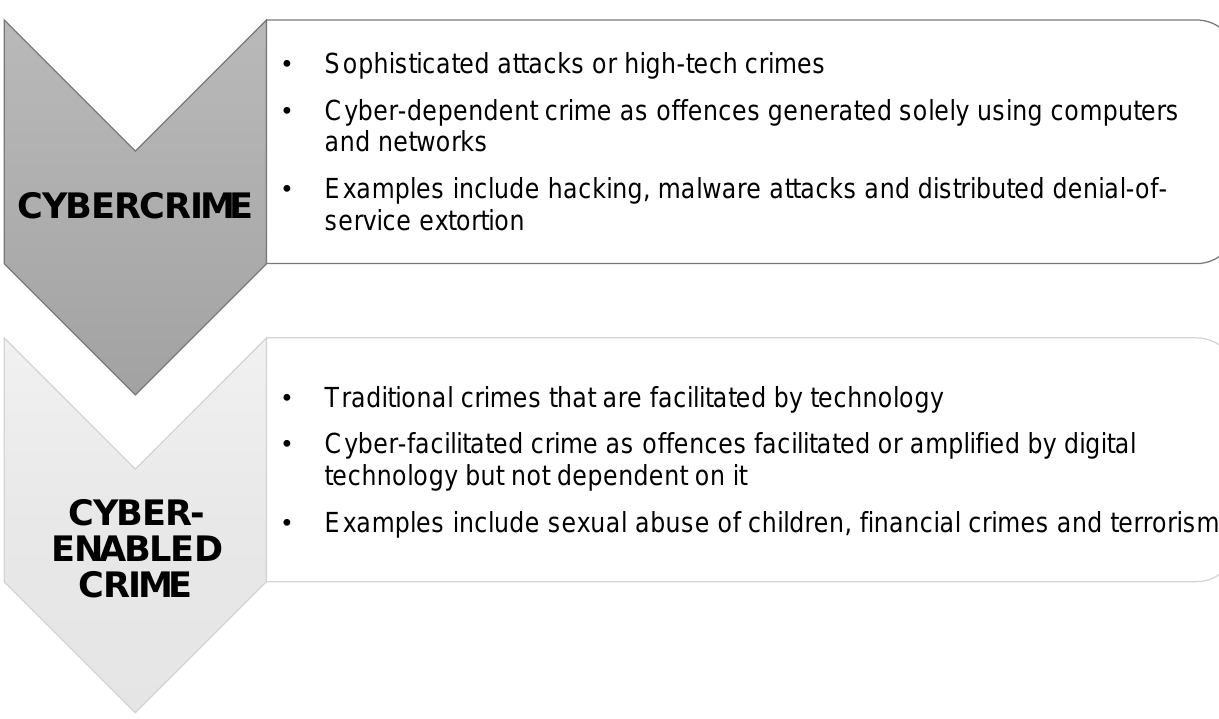
Figure 1: Distinction between cybercrime and cyber-enabled crime in a policing context (Adapted from The INTERPOL Foundation n.d.; Wilson-Kovacs